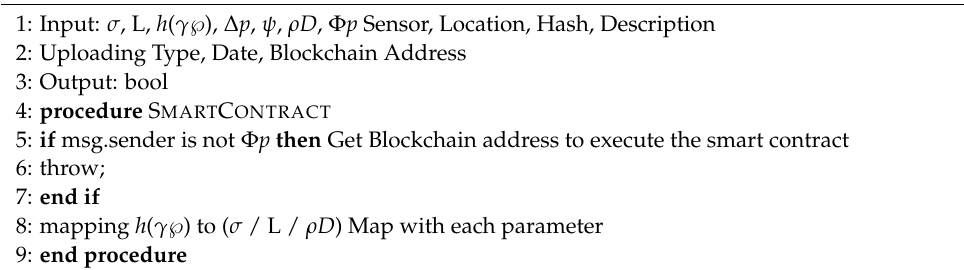
Algorithm 1 Contract